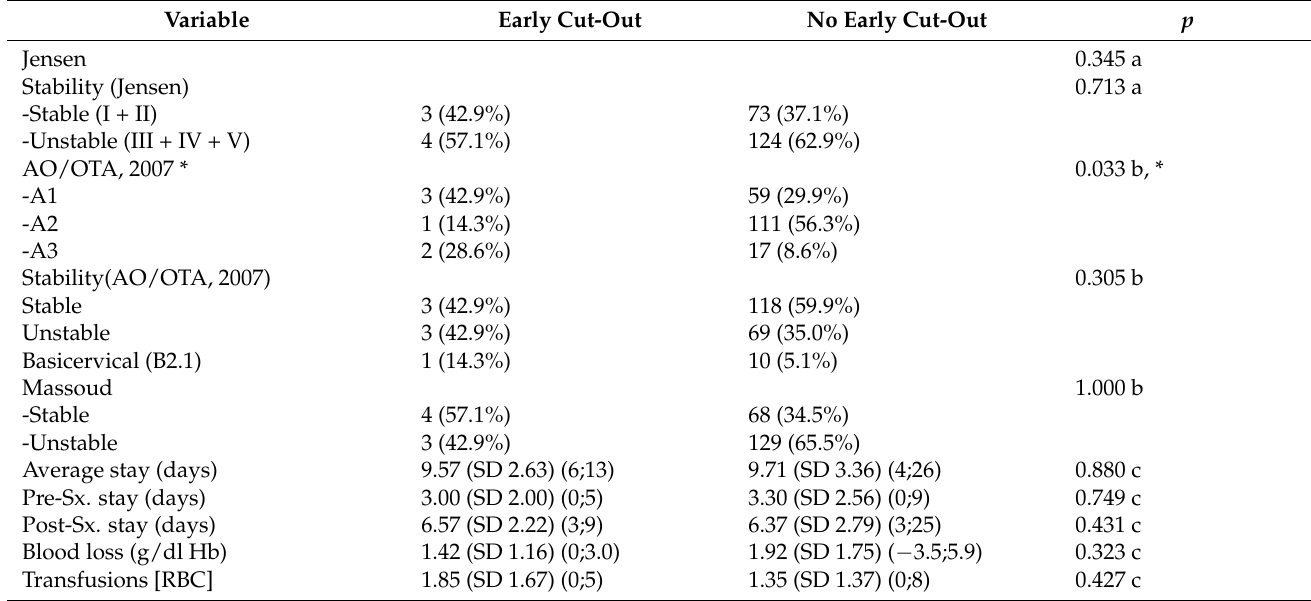
Table 2. Perioperative variables. Tests: a, Fisher’s exact test; b, Pearson’s chi-square test; c, Mann– Whitney’s U test (AO/OTA, AO Foundation/Orthopaedic Trauma Association classification; Sx., surgery; [RBC], red blood cells concentrate). *, Statistically significative.